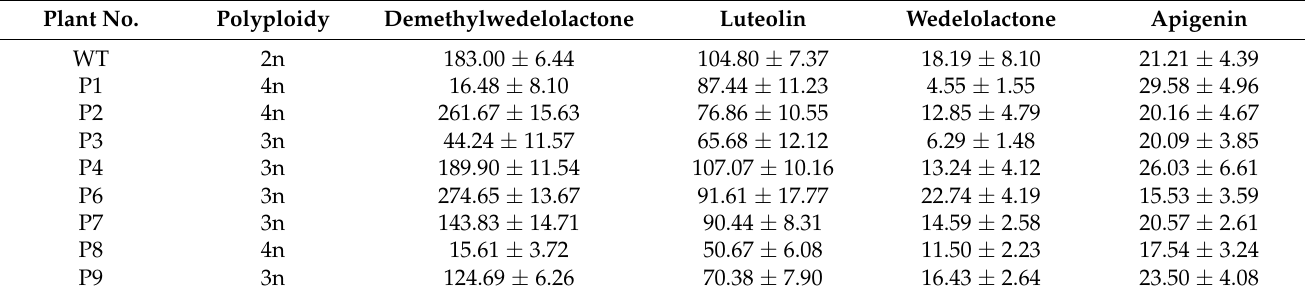
Table 3. Amounts of 4 metabolites ( µ g/g dry weight) in leaf tissue from diploid WT and polyploid plants. Plant